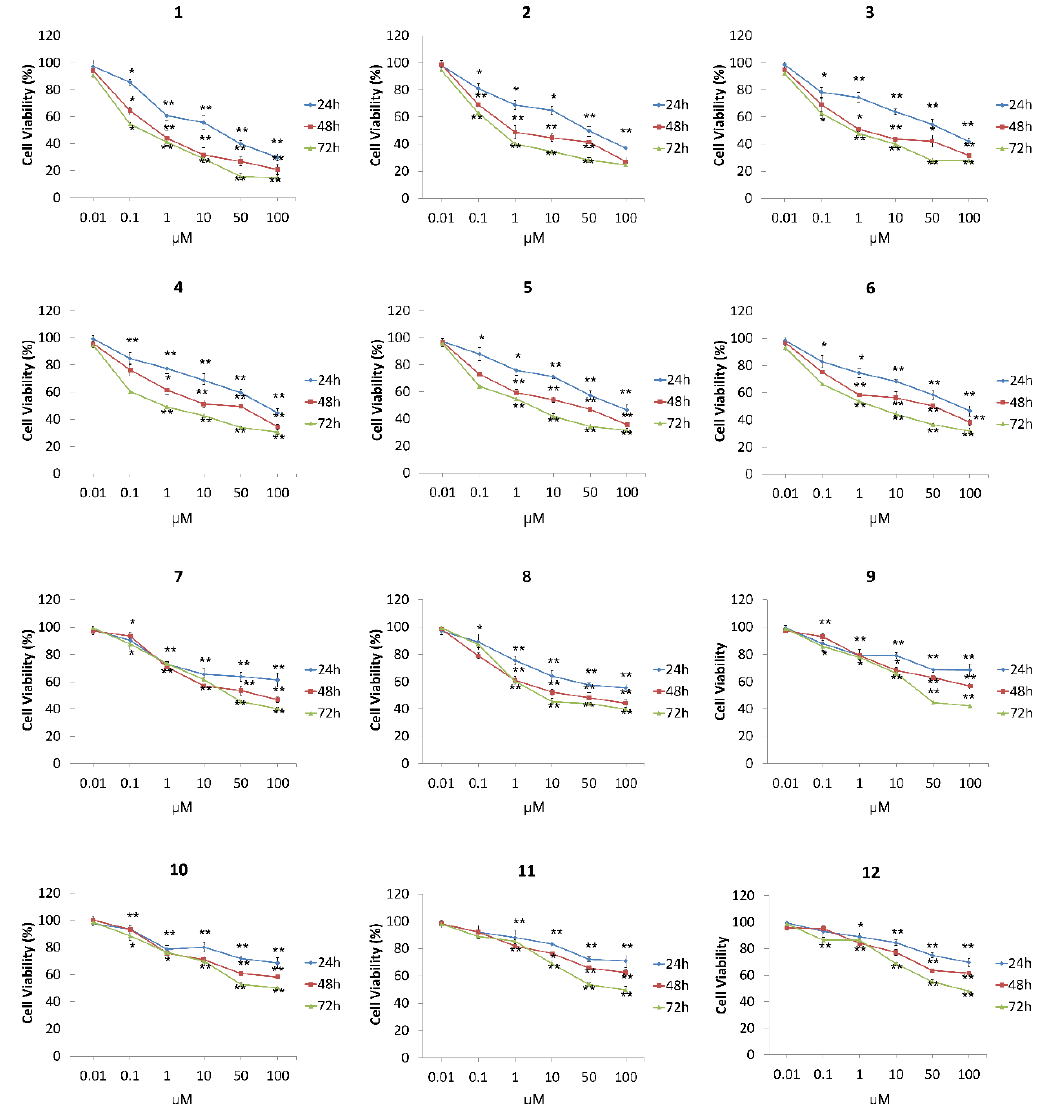
Figure 4. Dose-dependent response of MCF-7 epithelial breast cancer cells to test compounds 1 – 12 . The concentration range was from 0.01 to 100 µ M and the incubation time was 24, 48, and 72 h in a serum containing medium. Under the same conditions, results are presented as percentage of growth in respect to the control cells. Each point represents the mean ± standard deviation from the experiments in triplicate. Asterisks mark the statistically significant levels using the Student t-test: * p < 0.05, ** p < 0.01, respectively, as compared to control